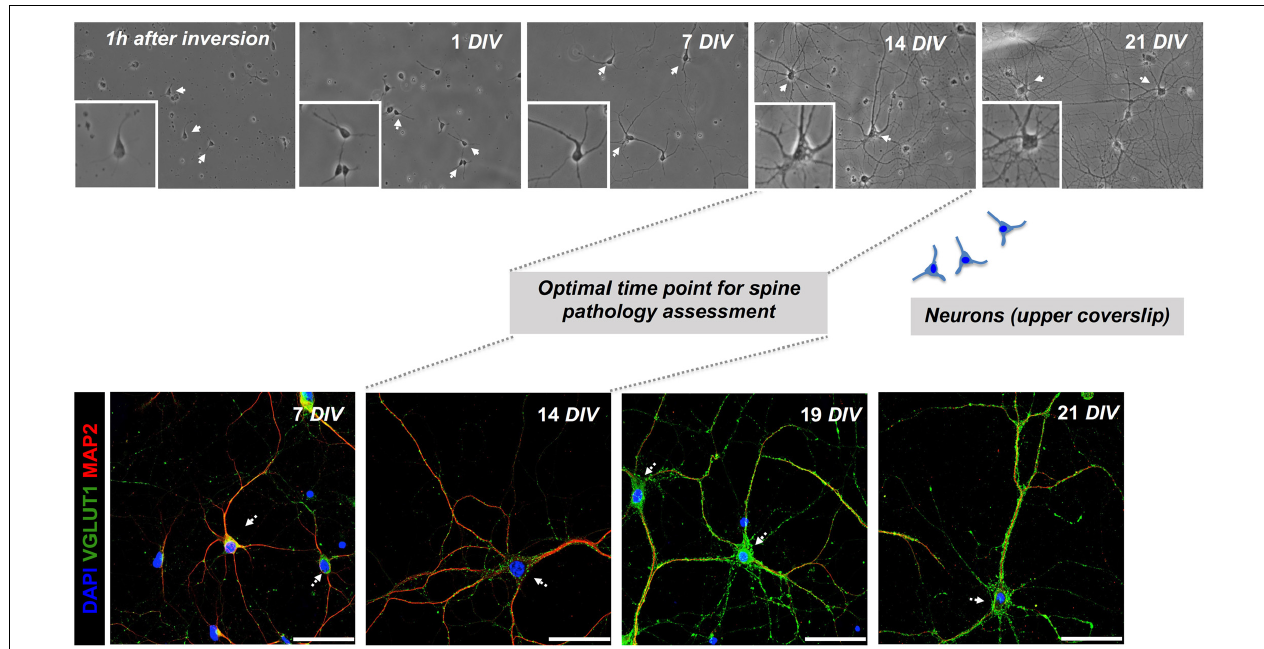
FIGURE 3 | Co-cultured neurons exhibit signs of maturity at 14 DIV . Monitoring the evolution of primary hippocampal neurons from day 1 up to 21 days in culture (DIV = days in vitro ) in sandwich co-cultures by serial wide-field analysis (upper row) and fluorescence staining and imaging (lower row). Our study determined the optimal time point for the assessment of dendritic spine morphology of neurons in the upper layer at day 14 of the co-culture. Representative fluorescence images of neuronal (MAP2) and synaptic (VGLUT1) markers are shown, scale bar = 50 µ m.